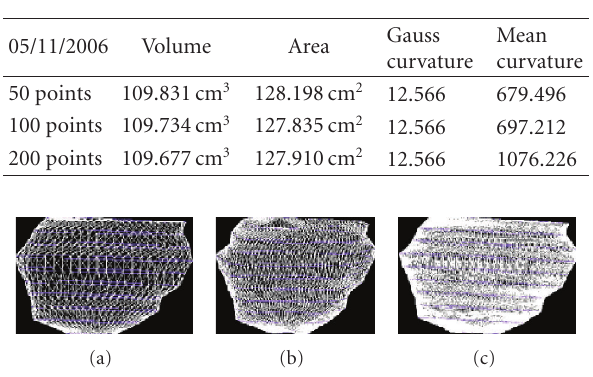
Figure 31: Patient 3. (a) 50 points on the contours, (b) 100 points on the contours, and (c) 200 points on the